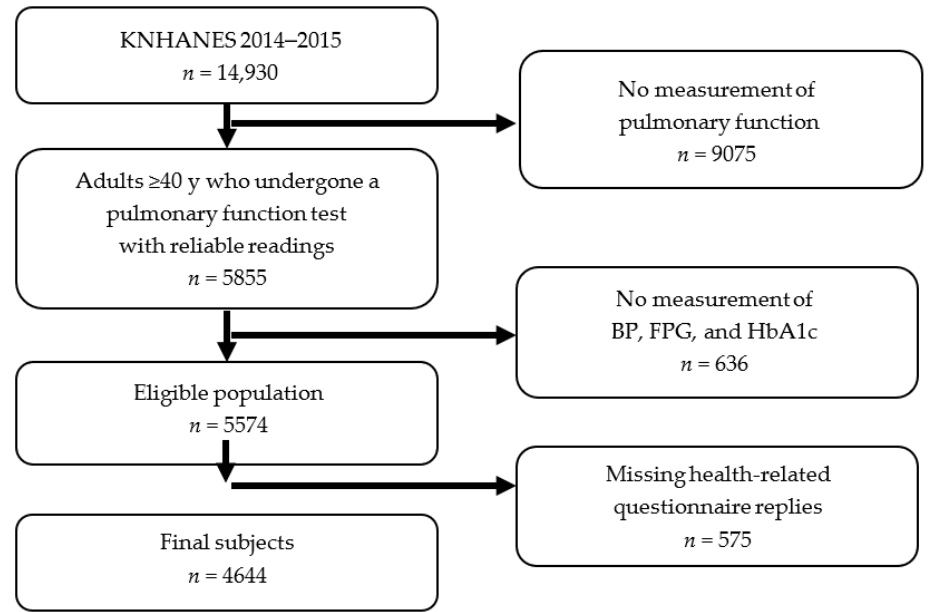
Figure 1. Flow diagram showing the selection of study participants. Abbreviations: KNHANES, Korean National Health and Nutrition Examination Survey; BP, blood pressure; FPG, fasting plasma glucose; HbA1c, Hemoglobin A1c